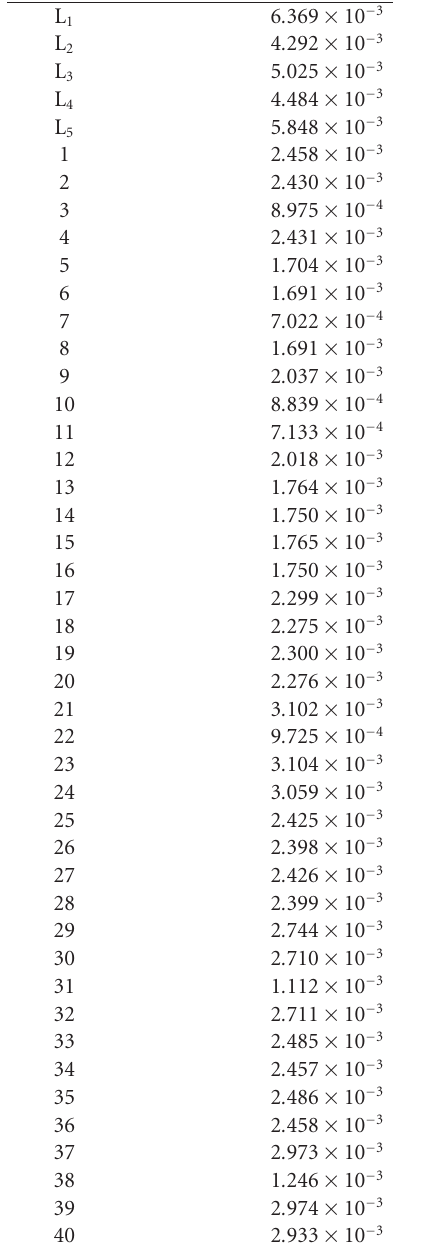
Table 6: Brine shrimp bioassay data of the ligands (L 1 )–(L 5 ) and their metal(II) complexes